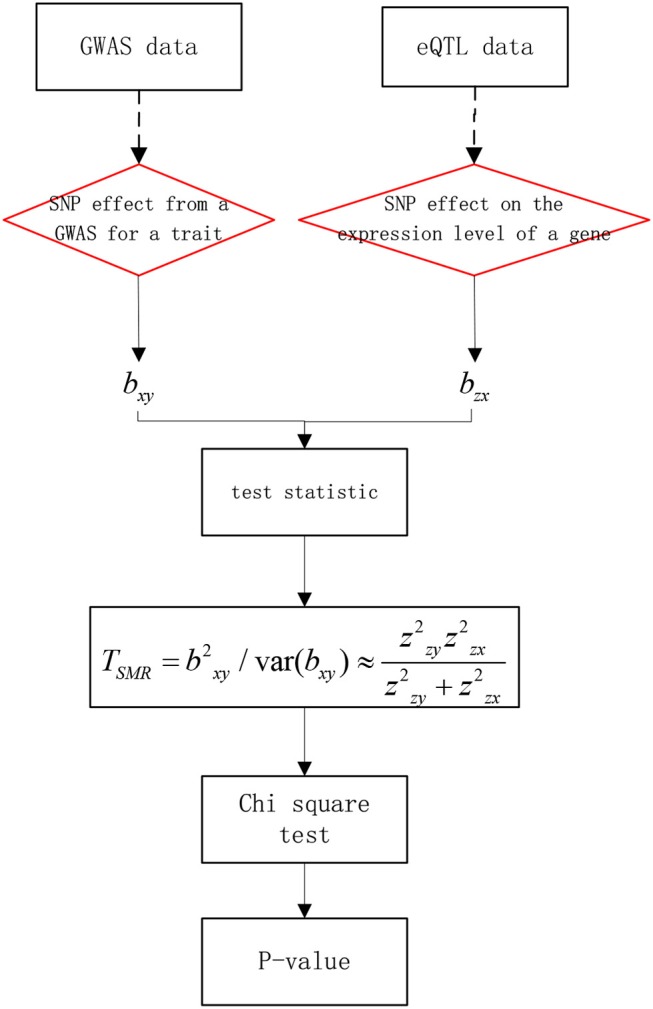
Work flow of SMR.